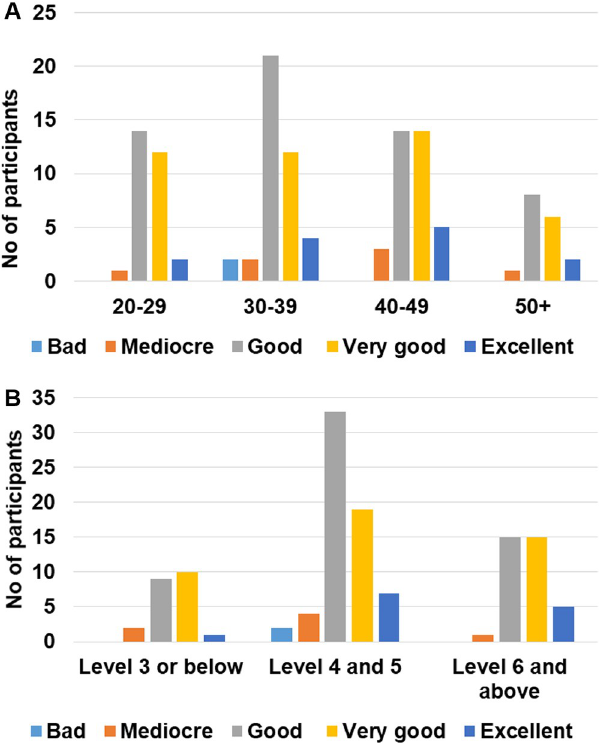
Fig 4. Description of the execution ratings according to the supervisors. Number of participants in each rating category according to age (A) or education level (B).